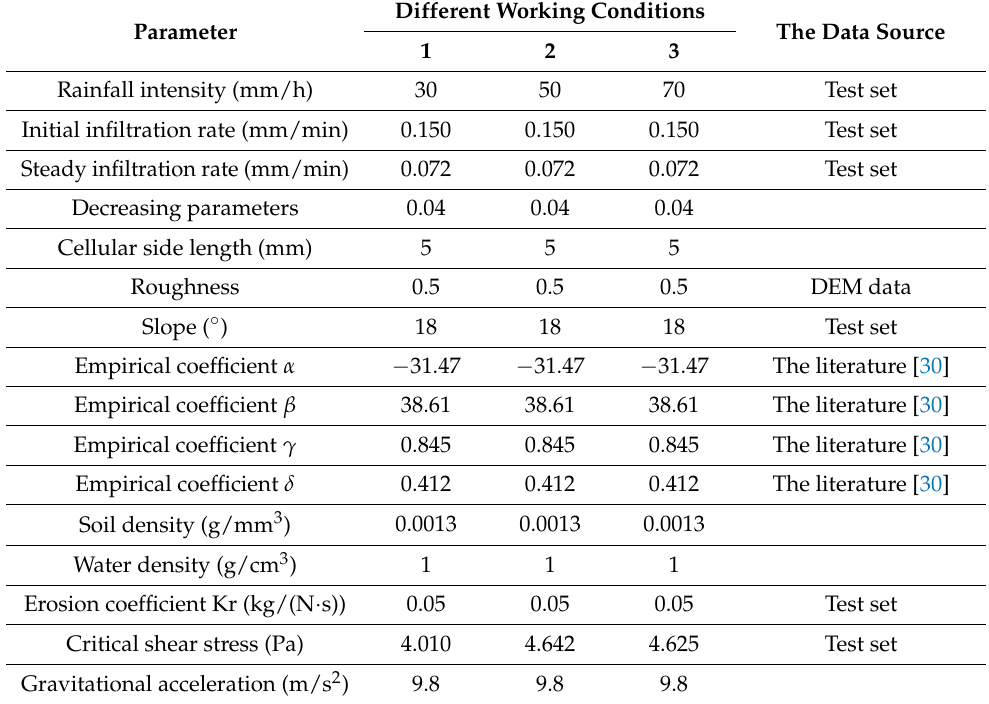
Table 2. Parameter values of black soil test